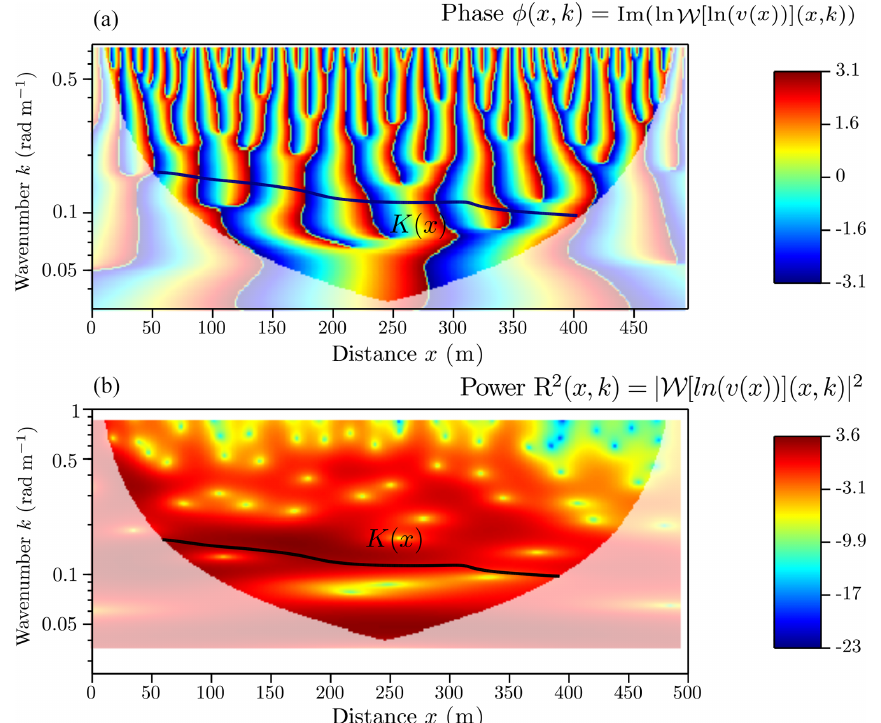
Figure 5. (a) The phase function from which we get the function K(x) ; (b) the power of the wavelet with the region where there is maximum variability depicted by the black curve K(x) (ridge curve). These two figures are represented in a wavenumber/distance space for the Olivet River, and the wavelet transform is performed on the logarithm of the velocity. The part of the figure with low opacity shows the cone of influence, which is ignored in this study (edge effects are more important for short wavelengths than for long